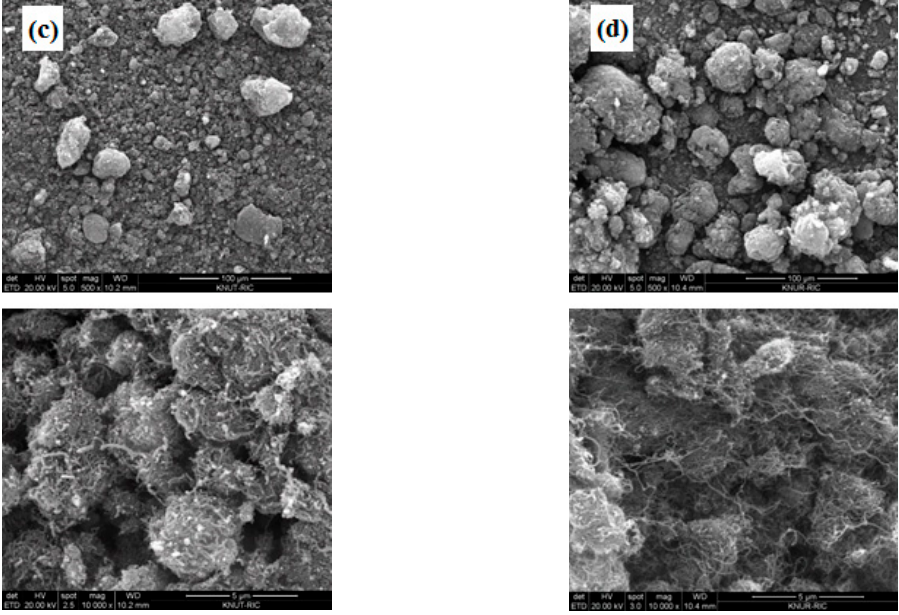
Figure 1. Characteristics of multi-walled Carbon Nanotube (CNT) particles in this study: ( a ) Raman spectrum analysis; ( b ) comparison of particle size distribution of CNT I and CNT II; ( c ) SEM images of CNT I; ( d ) SEM images of CNT II.